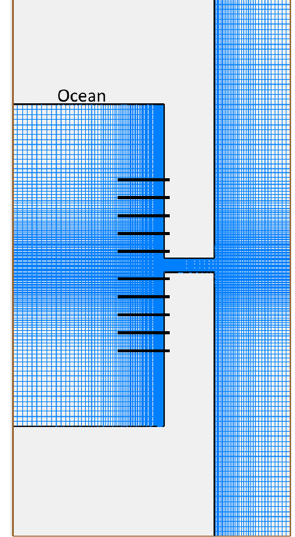
Figure 6. Humboldt model grid illustrating the location of the cross-shore transect placements. Similar transects were defined on all nine model grids to computer long-shore transport values.